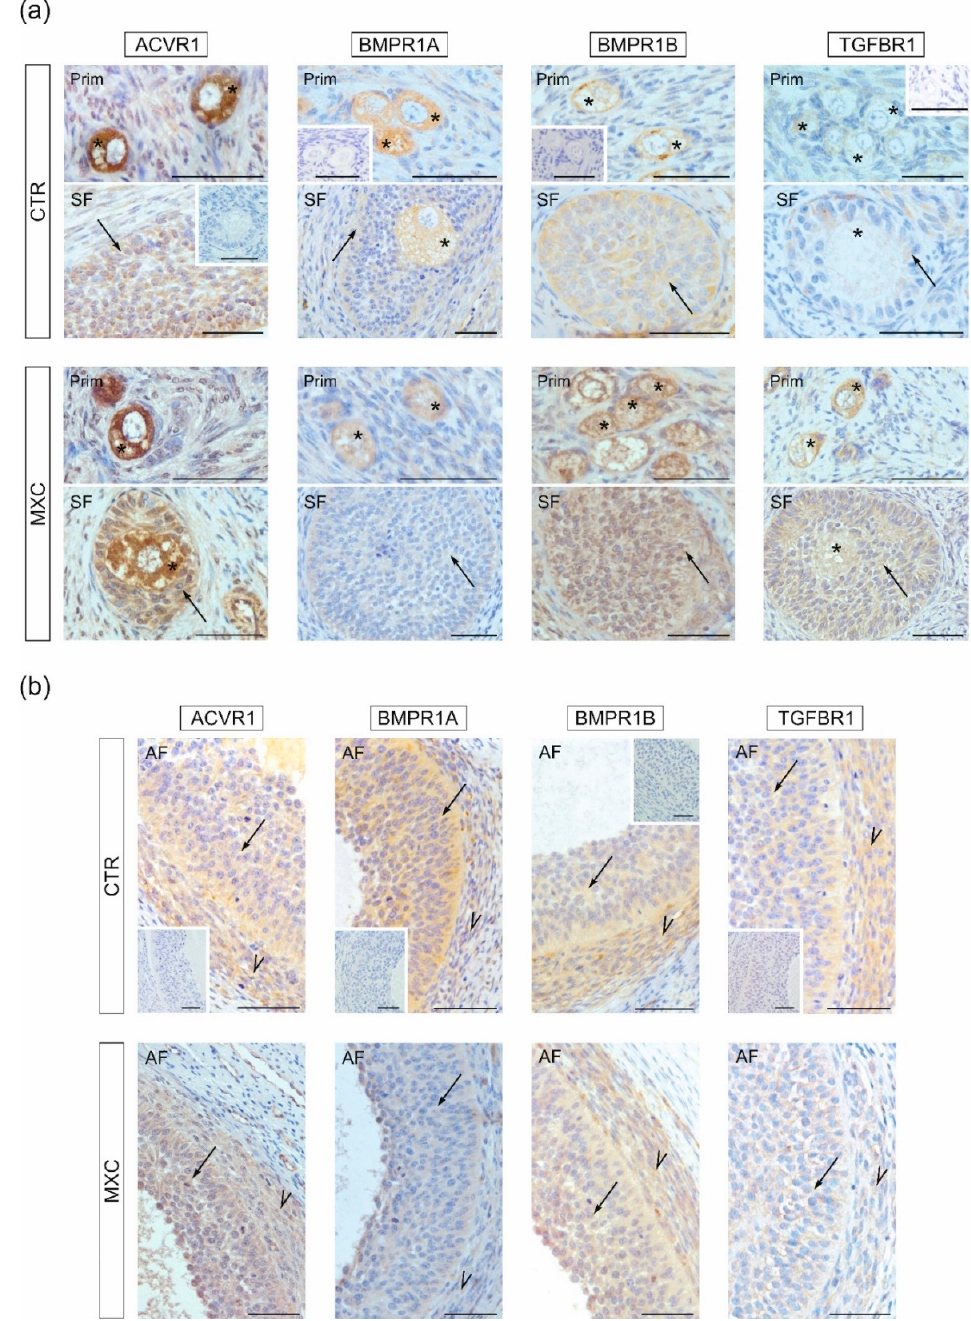
Figure 3. Immunolocalization of ACVR1, BMPR1A, BMPR1B, and TGFBR1 in preantral (primordial, primary, and secondary follicle) ( a ) and small antral ( b ) follicles of the control (CTR) and methoxychlor (MXC-) treated gilts. ACVR1, BMPR1A, BMPR1B, and TGFBR1 positive staining was observed in oocytes (asterisks) and granulosa cells (arrows) of preantral follicles, as well as granulosa (arrows) and theca cells (arrowheads) of small antral follicles, in both examined groups. All sections were counterstained with hematoxylin QS. There was no positive staining observed in the negative control sections ( a , b , insets). Prim—primordial follicles; SF—secondary follicles; AF—antral follicles. Bars = 50 μ m.